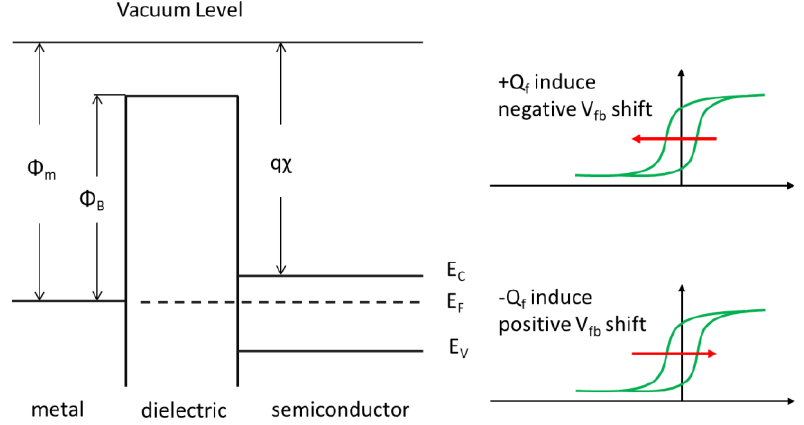
Figure 7. Work function of metals.